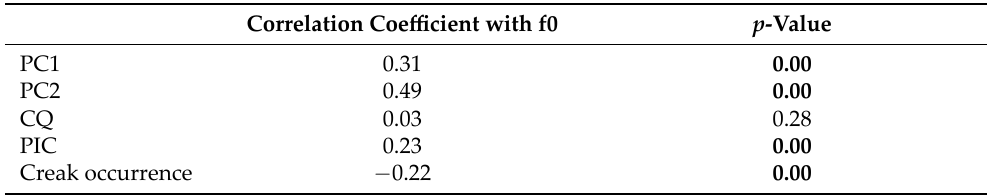
Table 9. Correlation between f0 and the voice‑quality measurements: PC1, PC2, CQ, PIC, and creak occurrence. Significant p ‑values ( p ⩽ 0.05 ) are marked in bold.